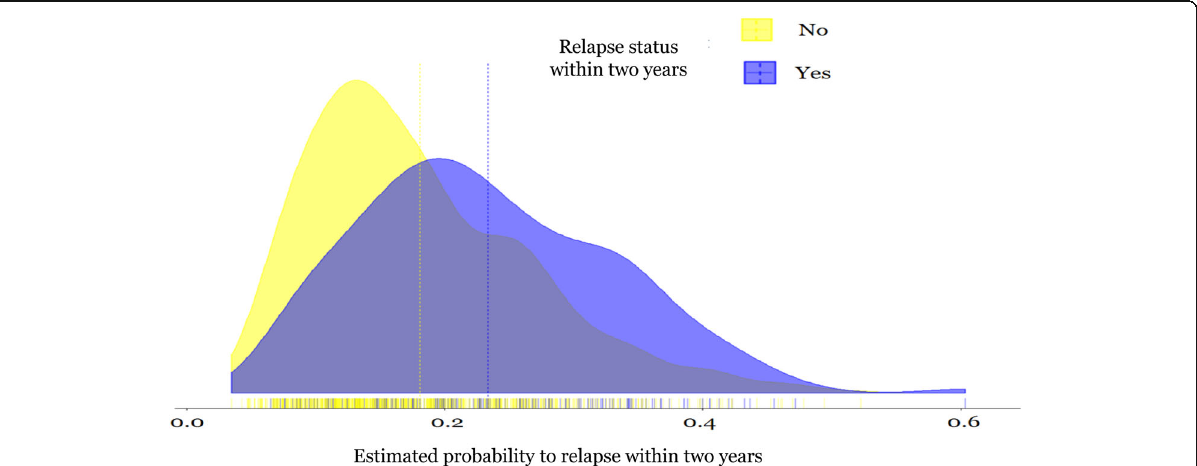
Fig. 2 The distribution of probability of relapsing within the next 2 years by relapse status at the end of 2-year follow-up cycles. The dashed lines indicate the mean of estimated probability/risk for cycles that ended up with relapse (purple) and for those without relapse